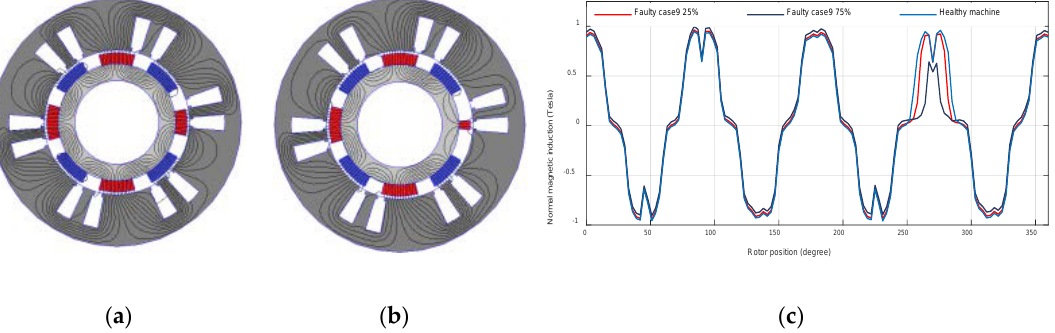
Figure 17. Faulty case 9: ( a ) Magnetic field under 25%; ( b ) magnetic field under 75%; ( c ) airgap magnetic flux density.